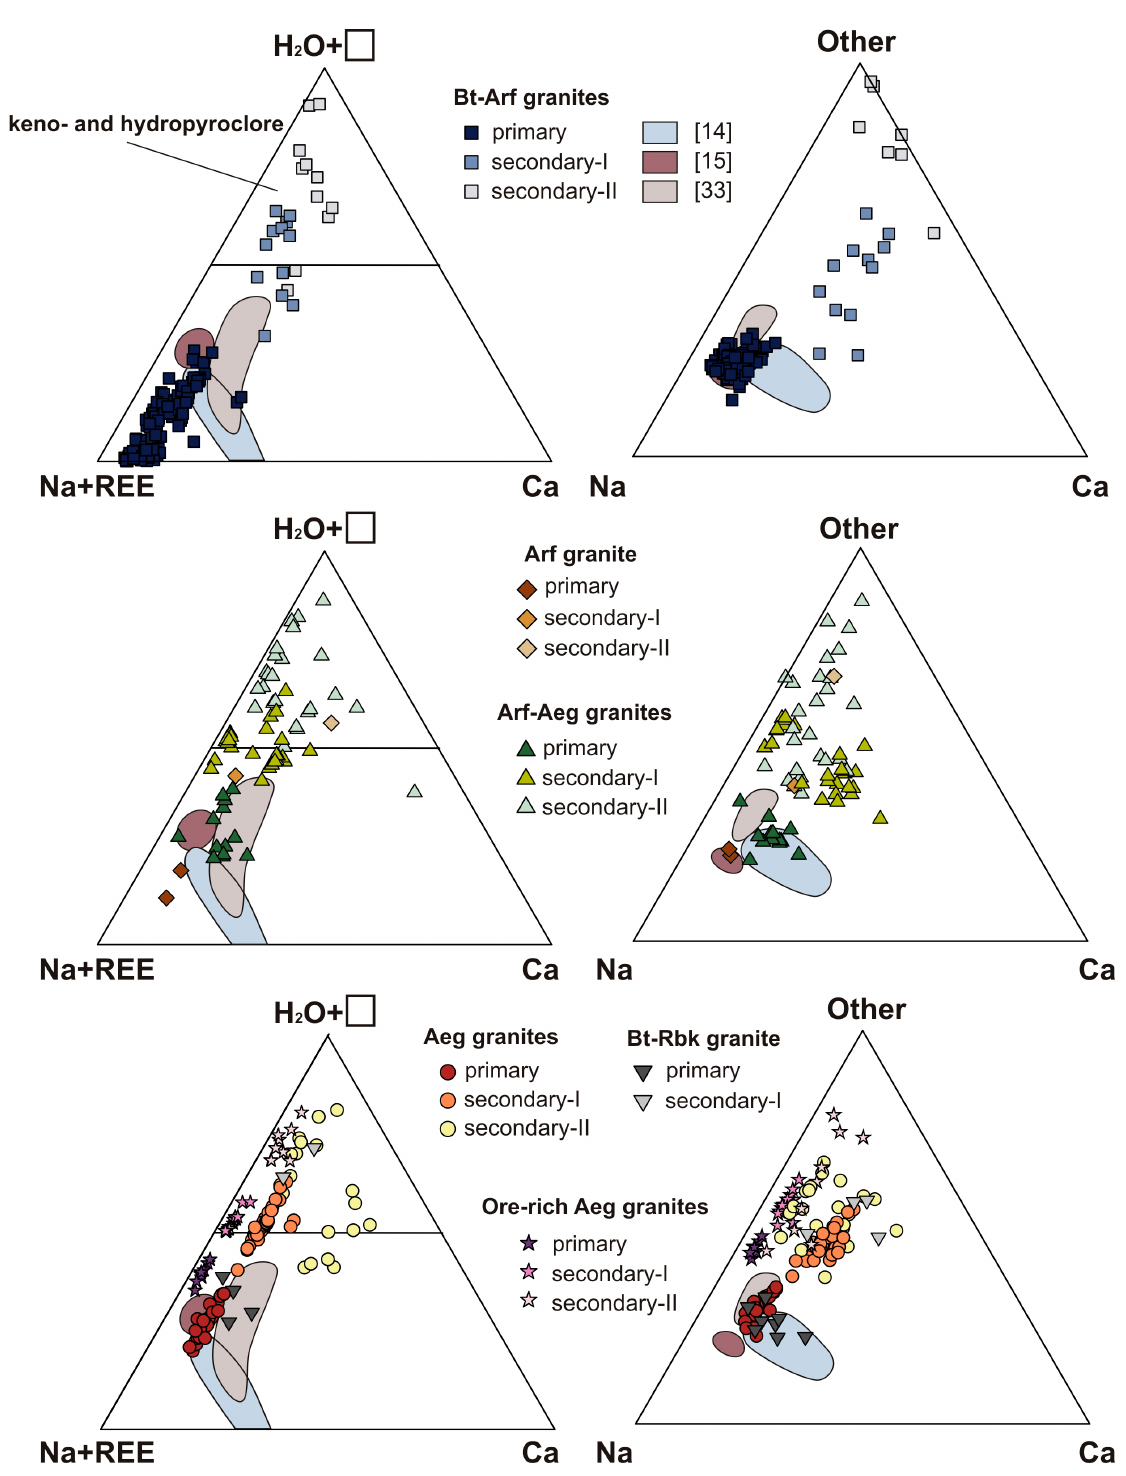
Figure 4. Ternary classification diagrams (A-site) for pyrochlore-group minerals from the Katugin granites. In the Ca-Na + REE-H 2 O + □ diagrams, Ca stands also for other divalent cations (Mn, Pb, Sr, Ba); Na+REE stands also for Y, U, Th, and K; □ is vacancy.